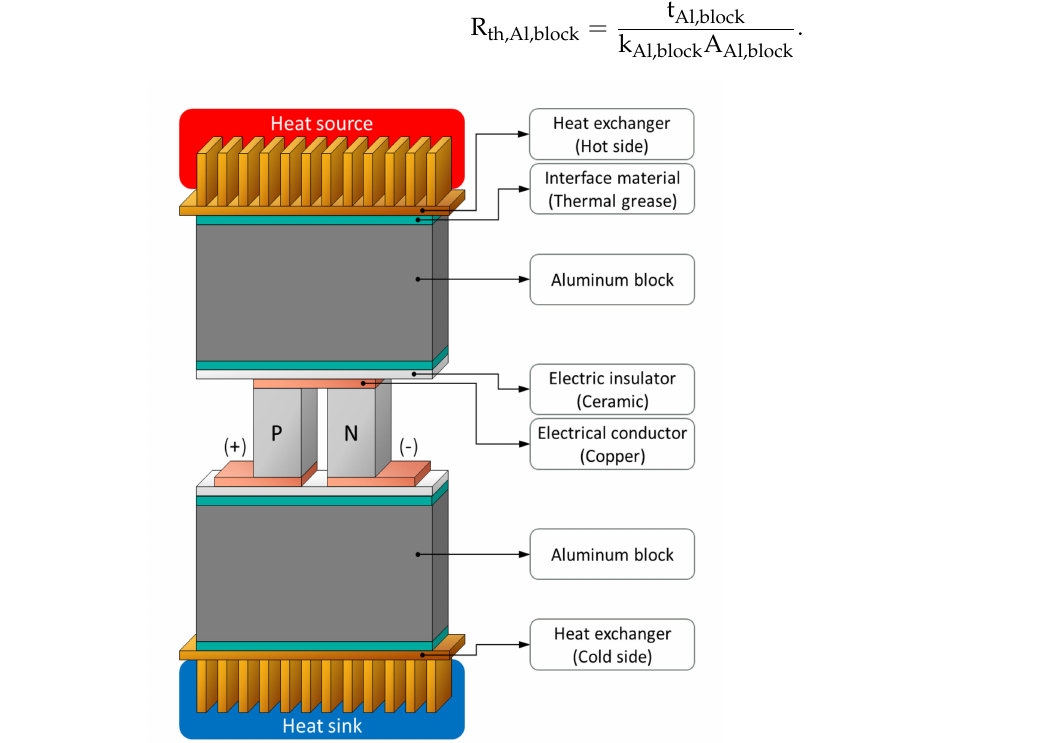
Figure 10. Integration of thermoelectric module in a thermoelectric